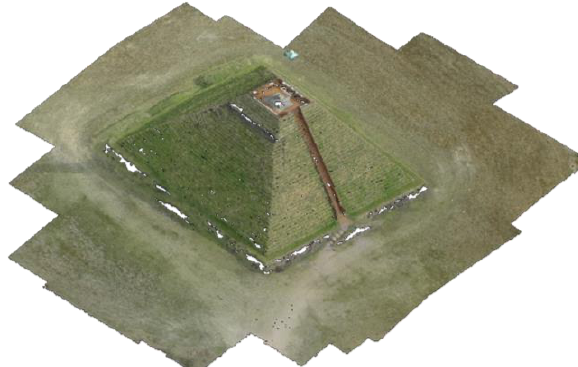
Figure-4: Computed 3D pointcloud of the Pyramid